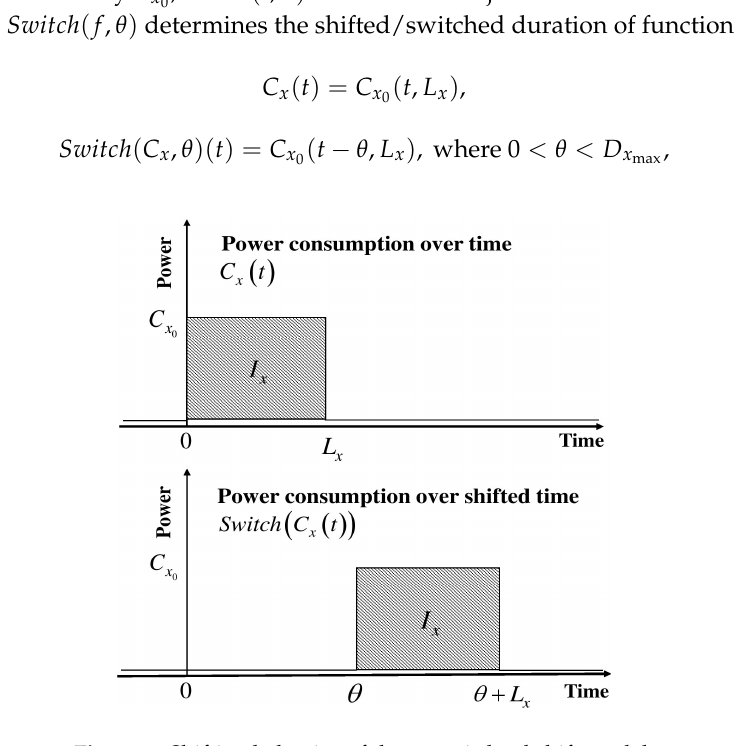
. Figure 2 depicts the typical behavior of FLSM [32].